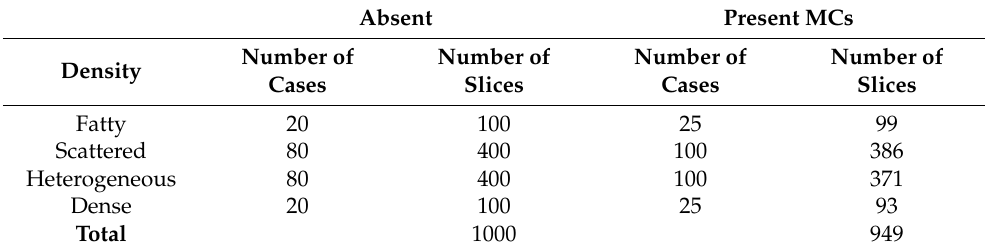
Table 2. Detailed summary of the VICTRE data selected for this study.